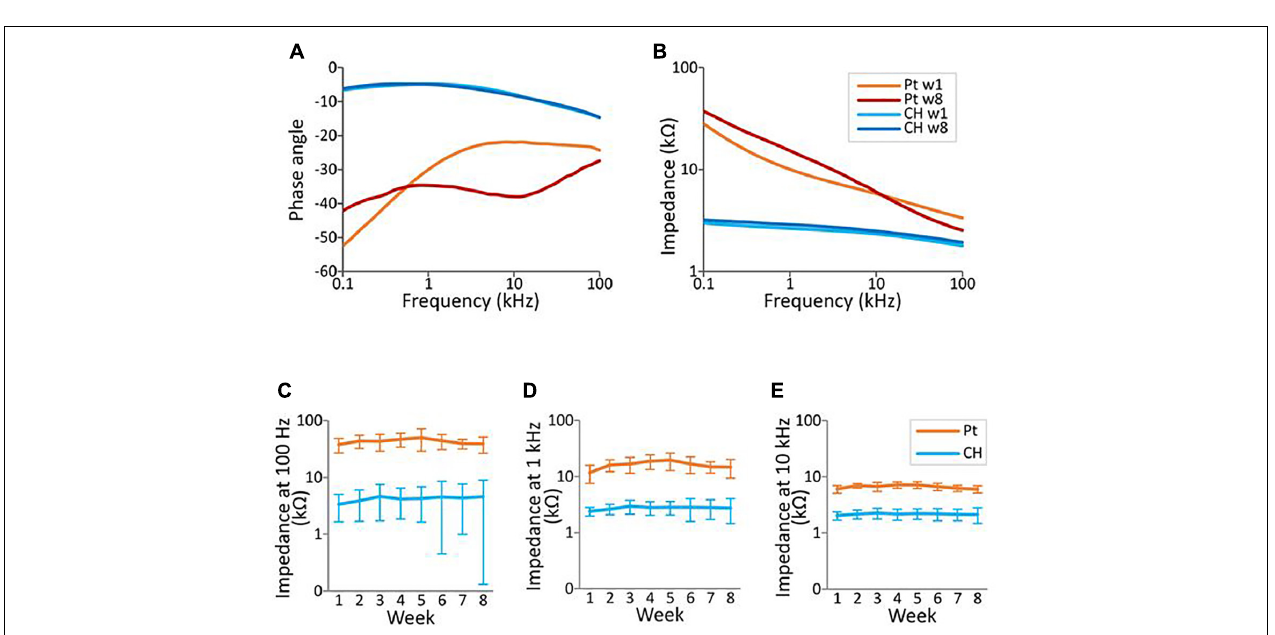
FIGURE 7 | Electrochemical impedance spectroscopy (EIS) measurement in the rat brain. EIS was measured within the frequency range from 100 Hz to 100 kHz using a potentiostat. (A,B) Representative impedance and phase angle measurement of conductive hydrogel-coated (CH) and uncoated platinum (Pt) electrodes at the start (w1, week 1) and end (w8) of chronic implantation. (C–E) All graphs represent mean ± SD. CH electrodes had significantly lower impedance at 100 Hz, 1 kHz, and 10 kHz throughout the duration of the study ( p ’s < 0.001, three-way ANOVAs, 28 Pt electrodes, 24 CH electrodes). There was no significant effect of duration of implantation or electrode contacts at all three frequencies ( p ’s >